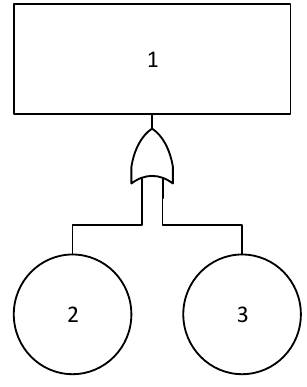
Figure A7. Fault tree of primary cooler natural circulation failure. Note: 1 = natural circulation of primary cooler fail. 2 = circulation flap fails to open/stuck (B16). 3 = pressure difference error (B17). 8.